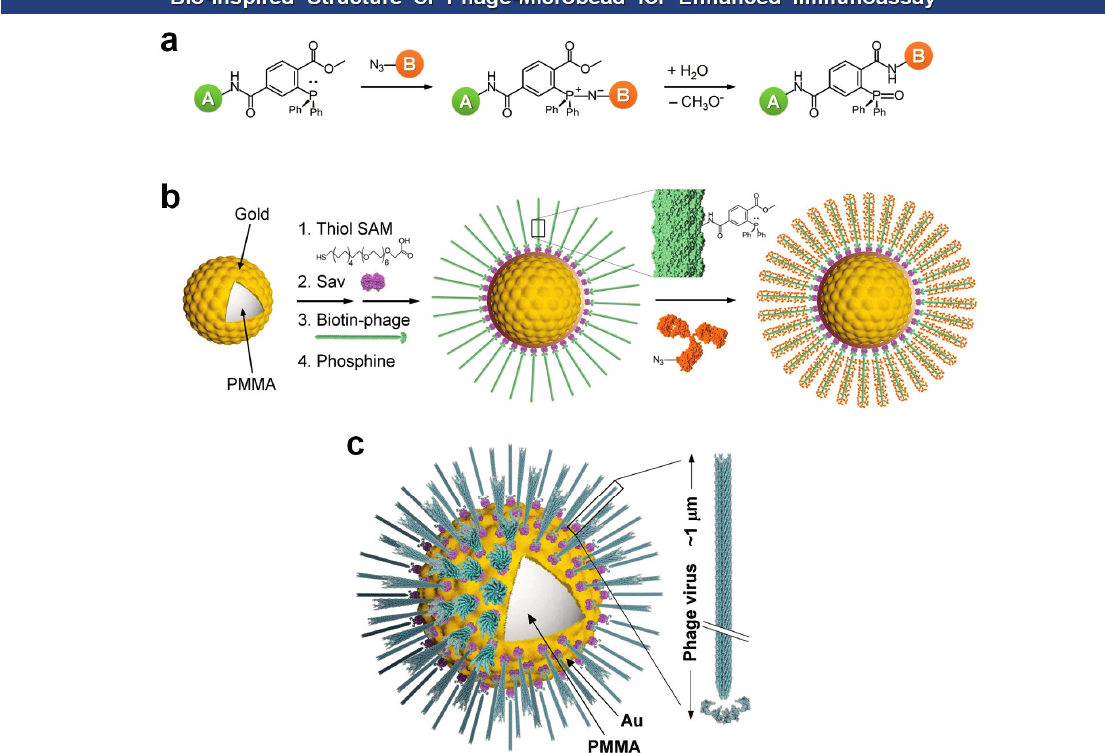
Figure 9. Schematics of Staudinger ligation ( a ) used in the fabrication of virus-Au microspheres ( b ); ( c ) Schematic representation of a bio-inspired virus-Au microsphere [91] (Copyright © 2013